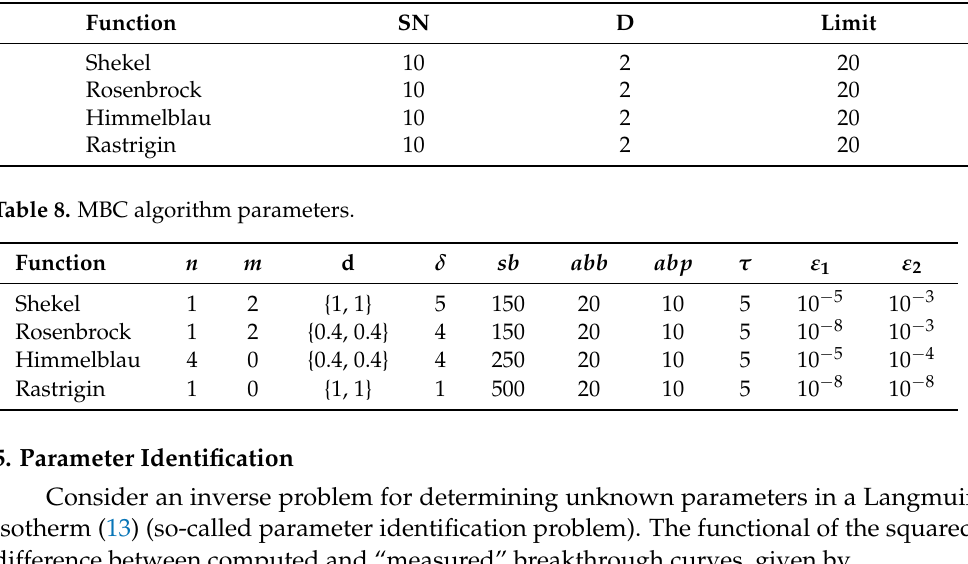
Table 7. ABC algorithm parameters.